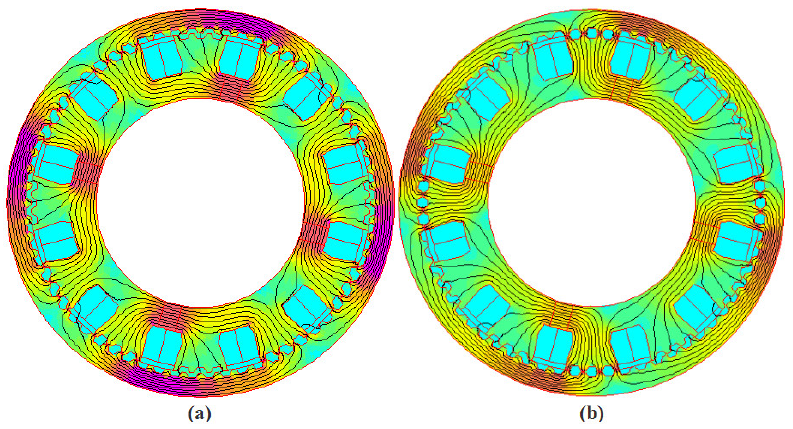
Figure 6. Important rotor positions of an ORDSPMG ( a ) “opposite” position, ( b ) “conjunction” position.